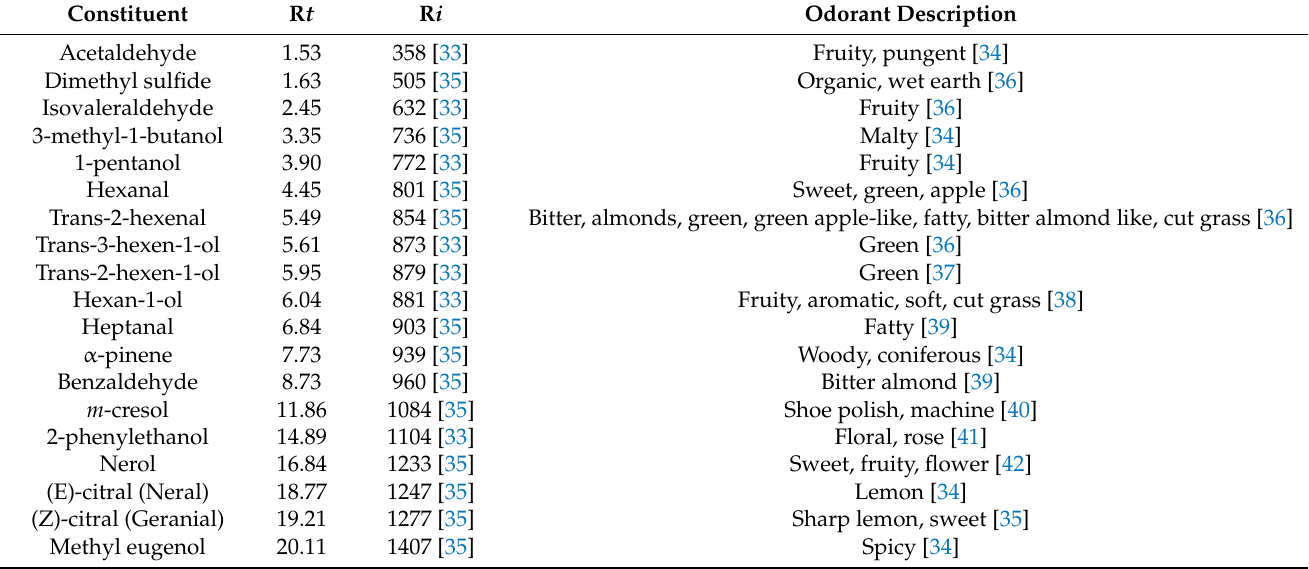
Table 2. List, retention time (R t ), Kovats index (R i ) and odorant description of the constituents identified both in petals and pollen of the 21 studied rose genotypes obtained by using the static headspace GC-MS